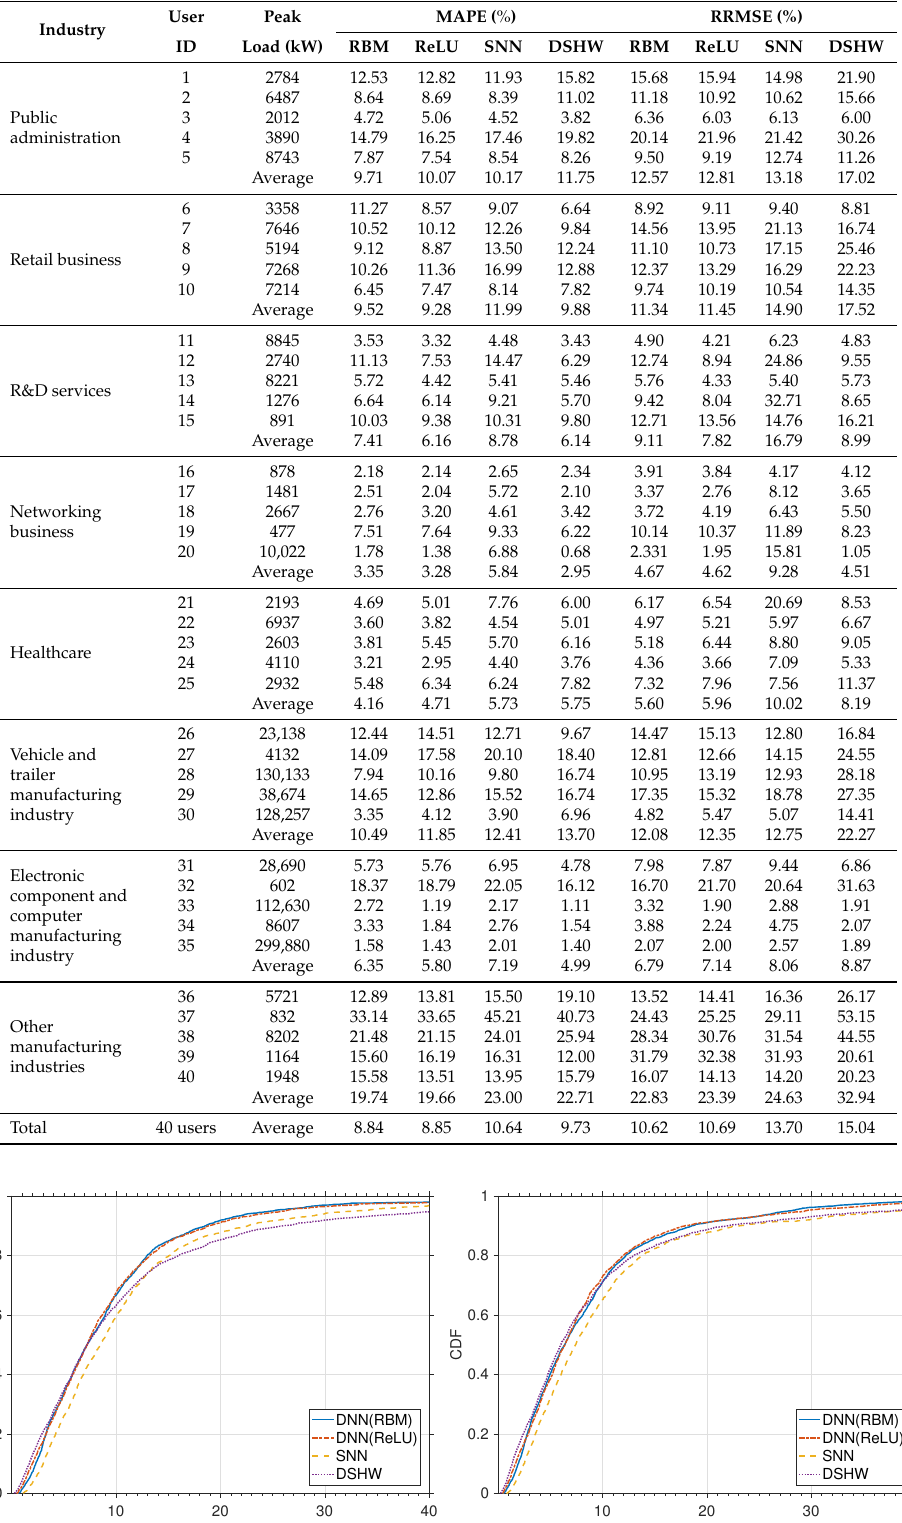
Table 3. Error table of various customers in 8 industries.